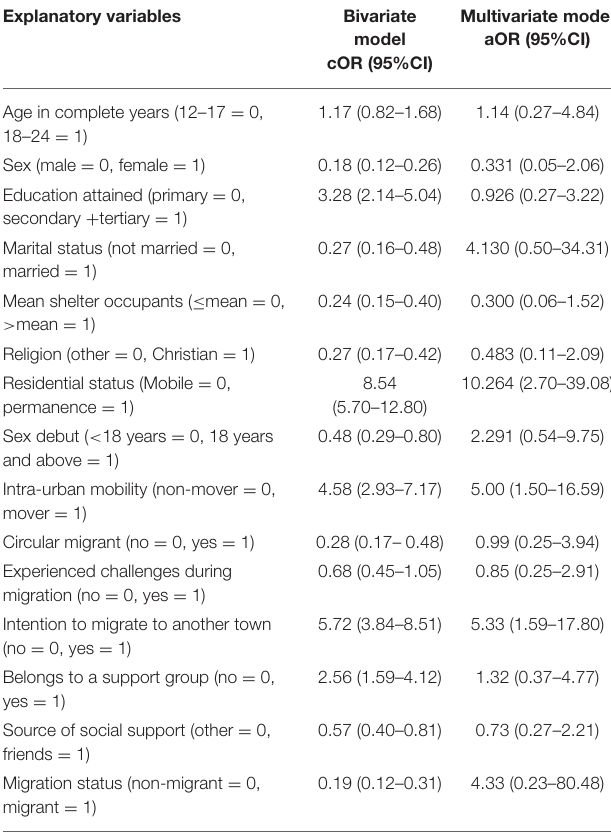
TABLE 2 | Model 1–Binary logistic regression of migration aspects and social demographic factors with personal childbearing decision-making among street adolescents and youth in Kampala, Uganda, 2019.